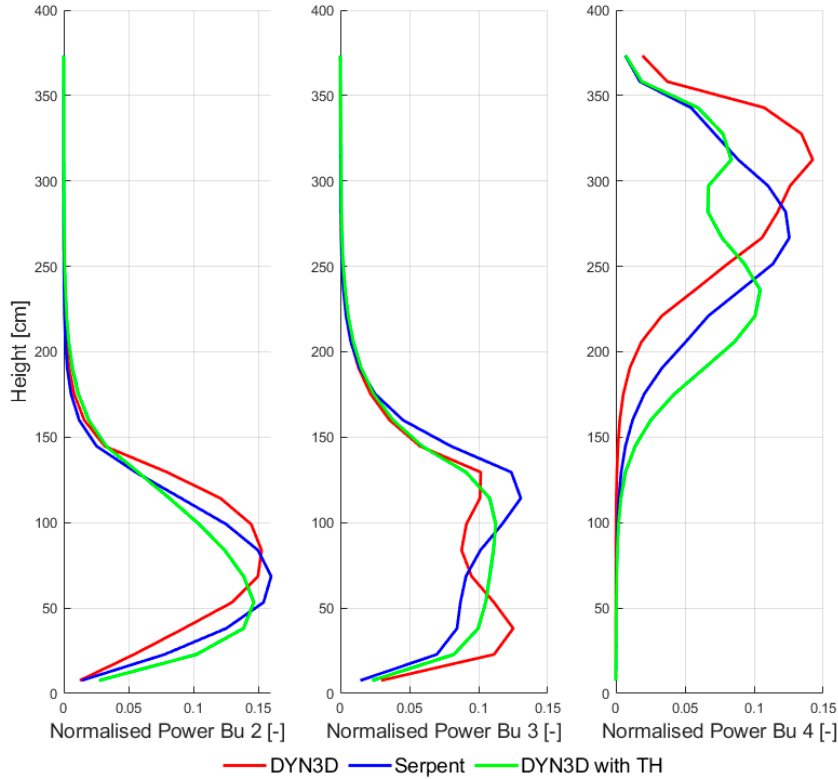
Figure 24. The normalised axial power profile for each burnup stage from left to right, 5, 10 and 30 GWd/TU for assembly one.